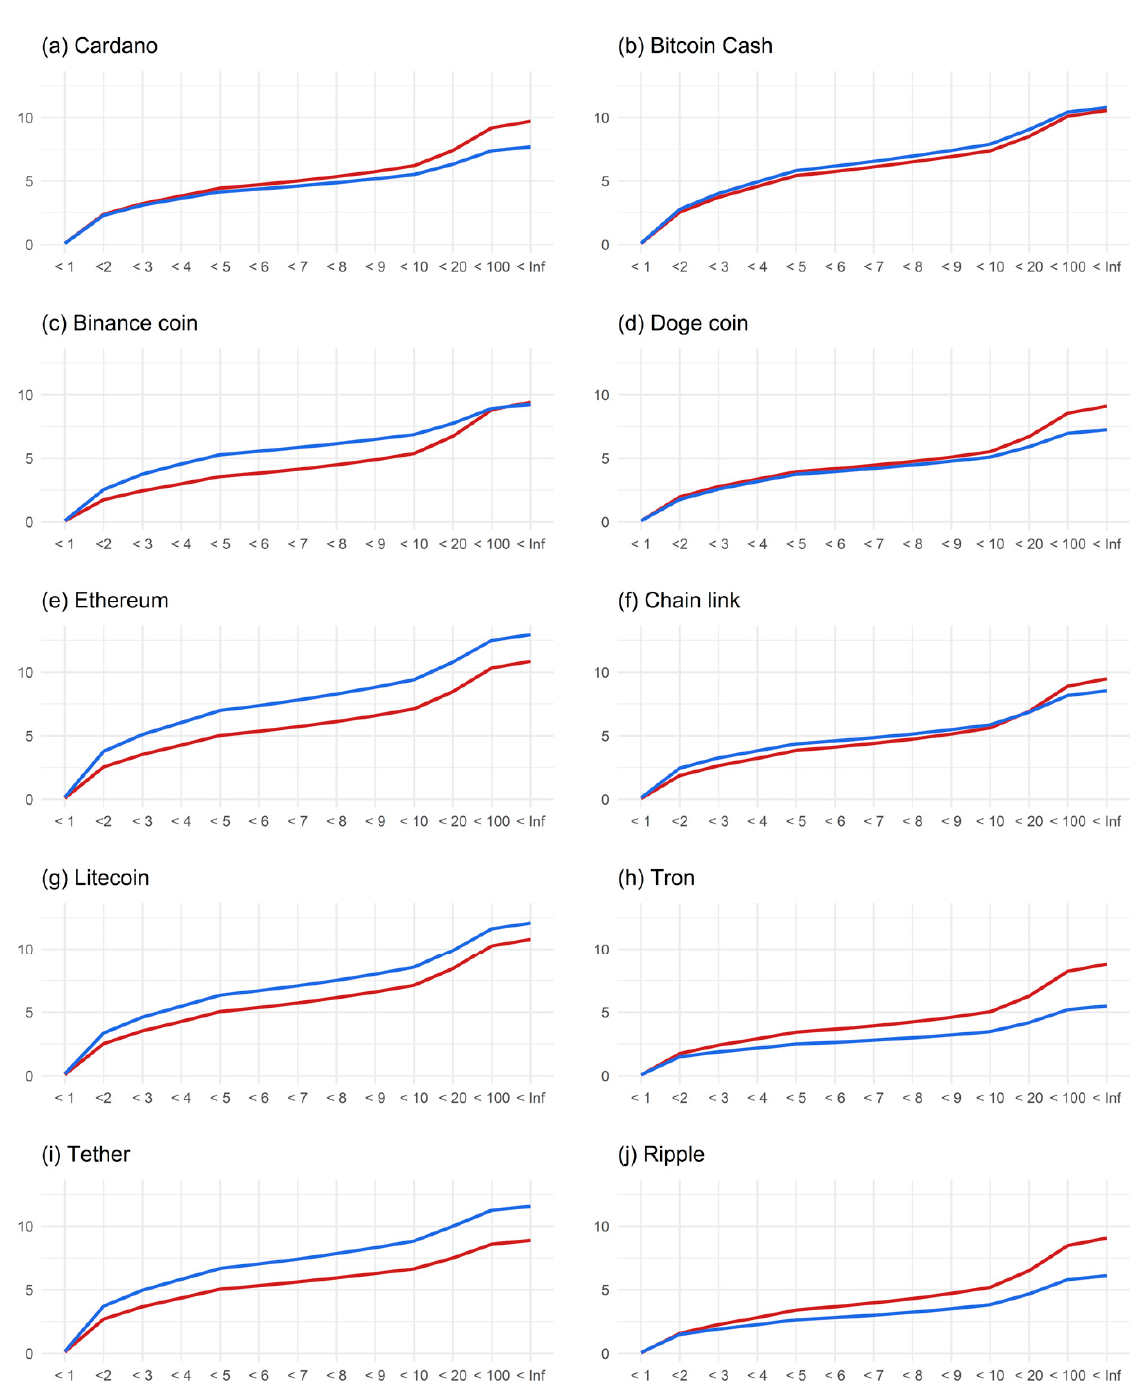
Figure 3. Short- and long-term volatility spillover from Bitcoin to altcoins during bear and bull market conditions. Note: The horizontal axis denotes the frequency in days, while the vertical axis denotes cumulative spillover index. The red and blue line shows the volatility spillover from Bitcoin to altcoins when bitcoin returns are negative (bear market condition) and positive (bull market condition), respectively.